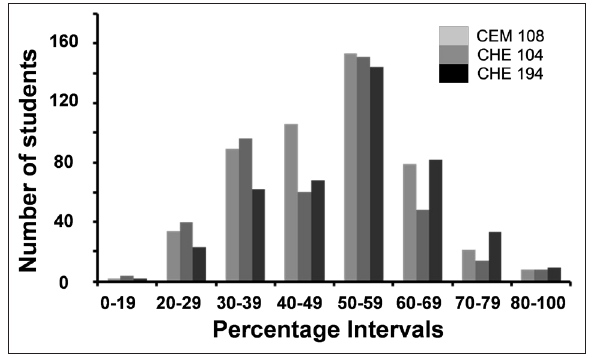
Figure 2: Performance of students in the University Preparation Pro- gramme in the first-year Chemistry modules (CEM108 over the period 1994–2005, CHE104 and CHE194 over the period 2006–2009).